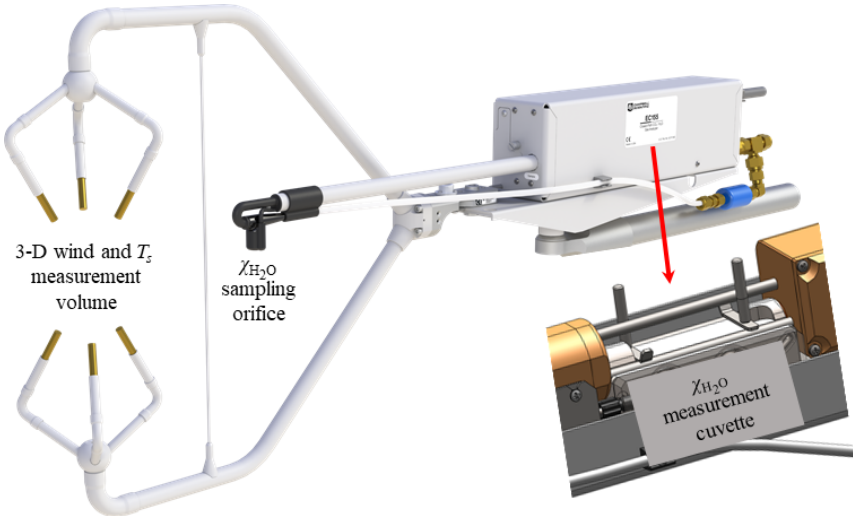
Figure 1. Measurement volume for three-dimensional (3-D) wind and sonic temperature ( T s ), sampling orifice for the H 2 O molar mixing ratio ( χ H ), and measurement cuvette for χ H in the CPEC300 series (Campbell Scientific Inc., UT, 2 O 2 O